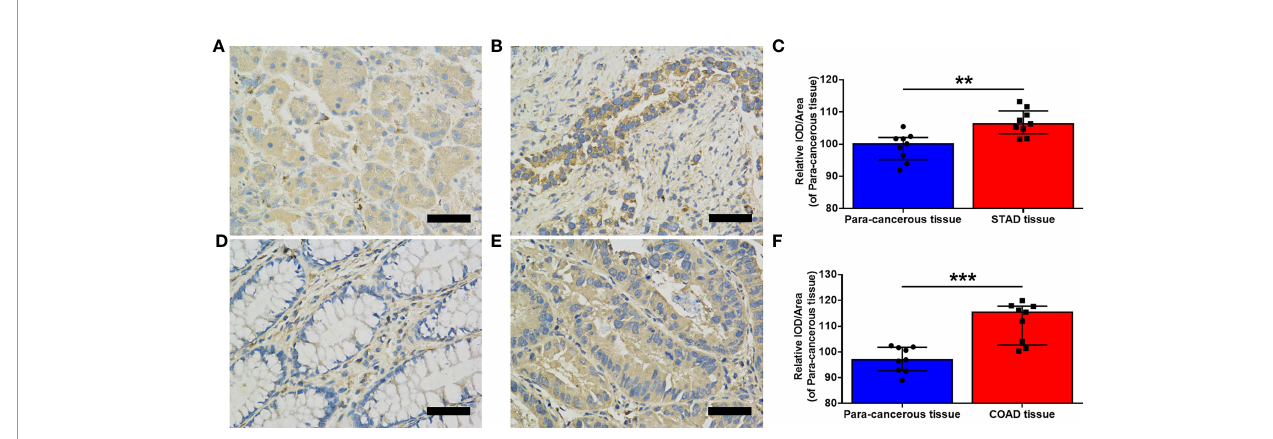
FIGURE 2 | Evaluation of MMP7 expression in stomach adenocarcinoma (STAD) and colon adenocarcinoma (COAD). (A, B) Representative immunohistochemistry (IHC) stained for MMP7 in the para-cancerous tissue (A) and tumor tissue (B) of the stomach, respectively. (C) Quantitation of MMP7 expression in the para- cancerous tissue and STAD tissue shown as mean density (integrated optical density (IOD)/area) plotted as means ± SD (n = 9). (D, E) Representative IHC stained for MMP7 in the para-cancerous tissue (D) and tumor tissue (E) of the colon, respectively. (F) Quantitation of MMP7 expression in the para-cancerous tissue and COAD tissue shown as mean density (IOD/area) plotted as means ± SD (n=9). Scale bar=50 m m. ** P < 0.01; *** P <